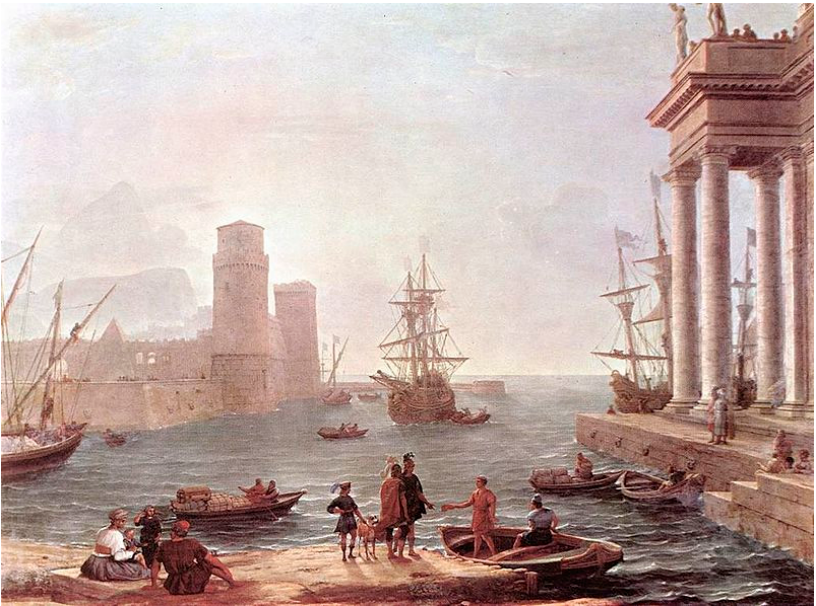
Figure 11. Departure of Ulysses from the Land of the Phaeacians: Claude Lorrain, 1646.